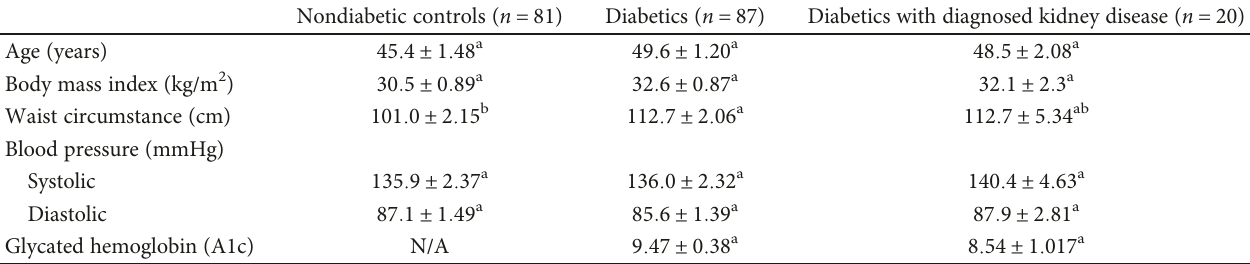
Table 1: Clinical characteristic of nondiabetic and diabetic